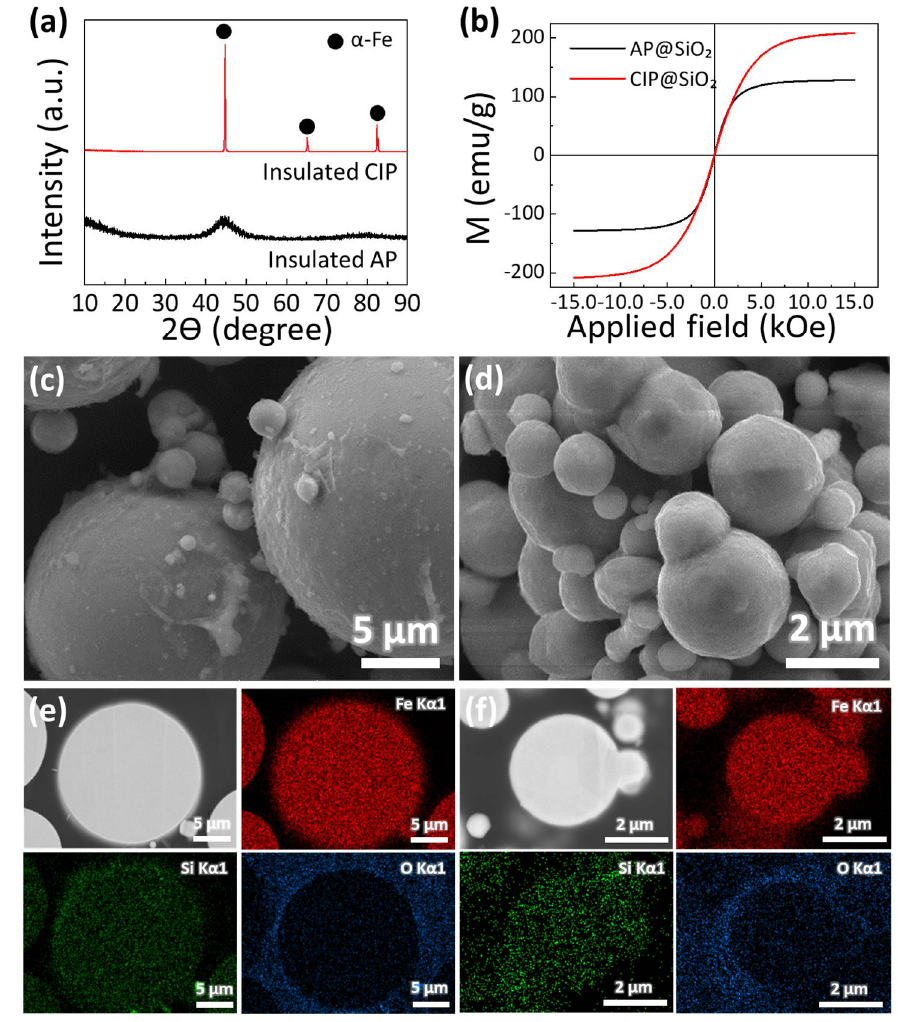
Figure 4. ( a ) XRD pattern of insulated amorphous powder and insulated carbonyl-iron powder. ( b ) Magnetic hysteresis loops of insulated amorphous powder and insulated carbonyl-iron powder. ( c , d ) SEM surface images of insulated ( c ) amorphous powder and ( d ) carbonyl-iron powder. ( e , f ) EDS element mapping results of insulated ( e ) amorphous powder and ( f ) CIPs.